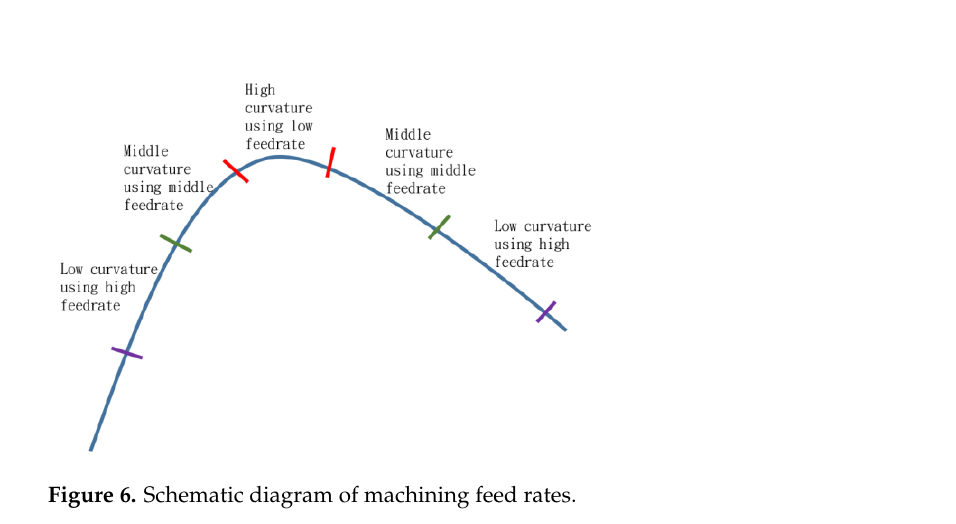
9 of 20 Figure 5. Membership functions of ( a ) curvature, ( b ) curvature variation, and ( c ) feed rate. When inputting the amount of curvature variation, it is first normalized to the inter- val [0, 1] based on the maximum and minimum values. After many experiments and ad- justments, if the curvature variation remains greater than 3, the curvature variation is rep- resented by the maximum value of 3 and is then normalized. The curvature does not need to be normalized and the output is the feed rate percentage. The current feed rate can be obtained by multiplying by the output with the maximum feed rate, and the user is able to adjust the maximum feed rate to meet the machining requirements. B. Establishment of fuzzy rules